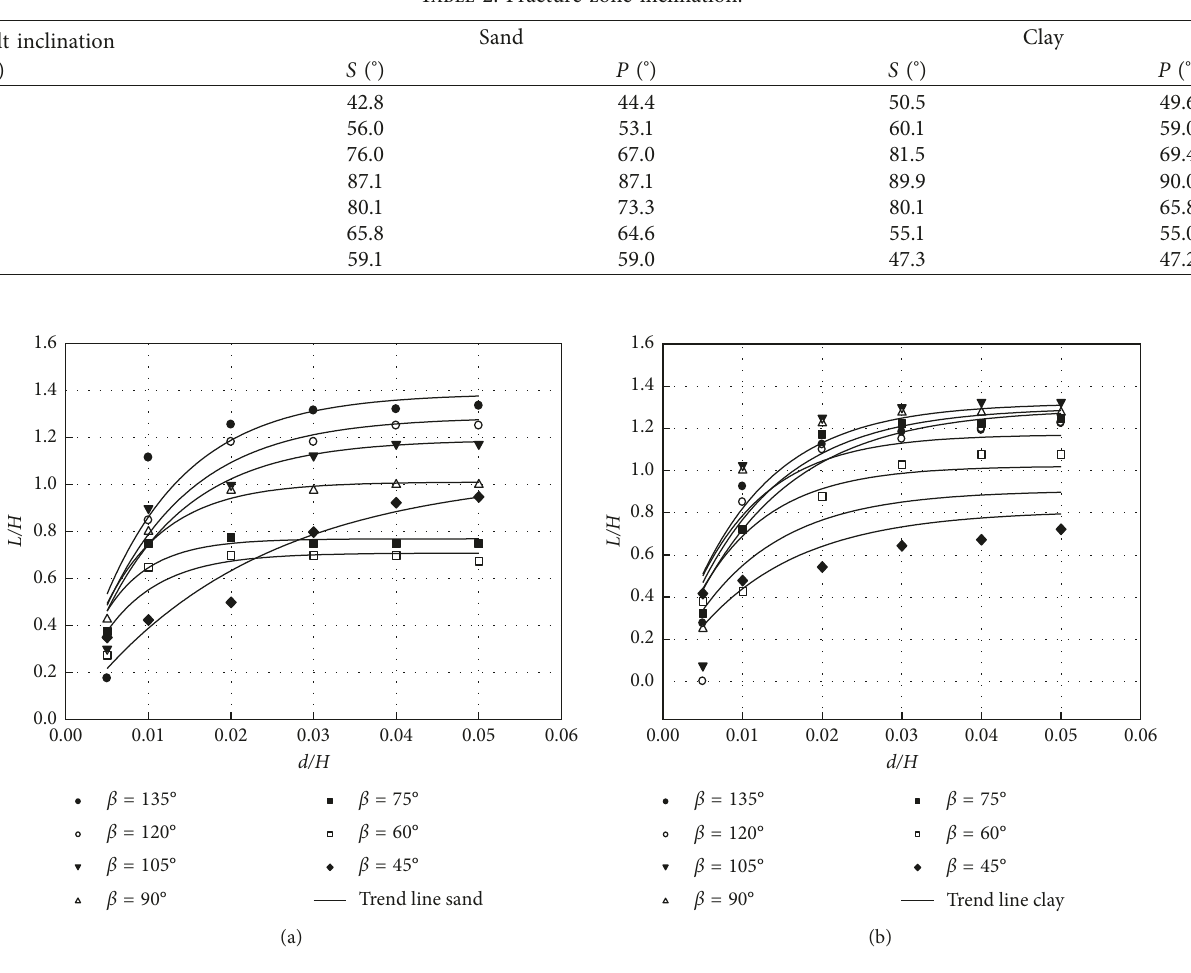
Figure 17: The relationship curves between L and d with different fault dip angles for (a) sand and (b)